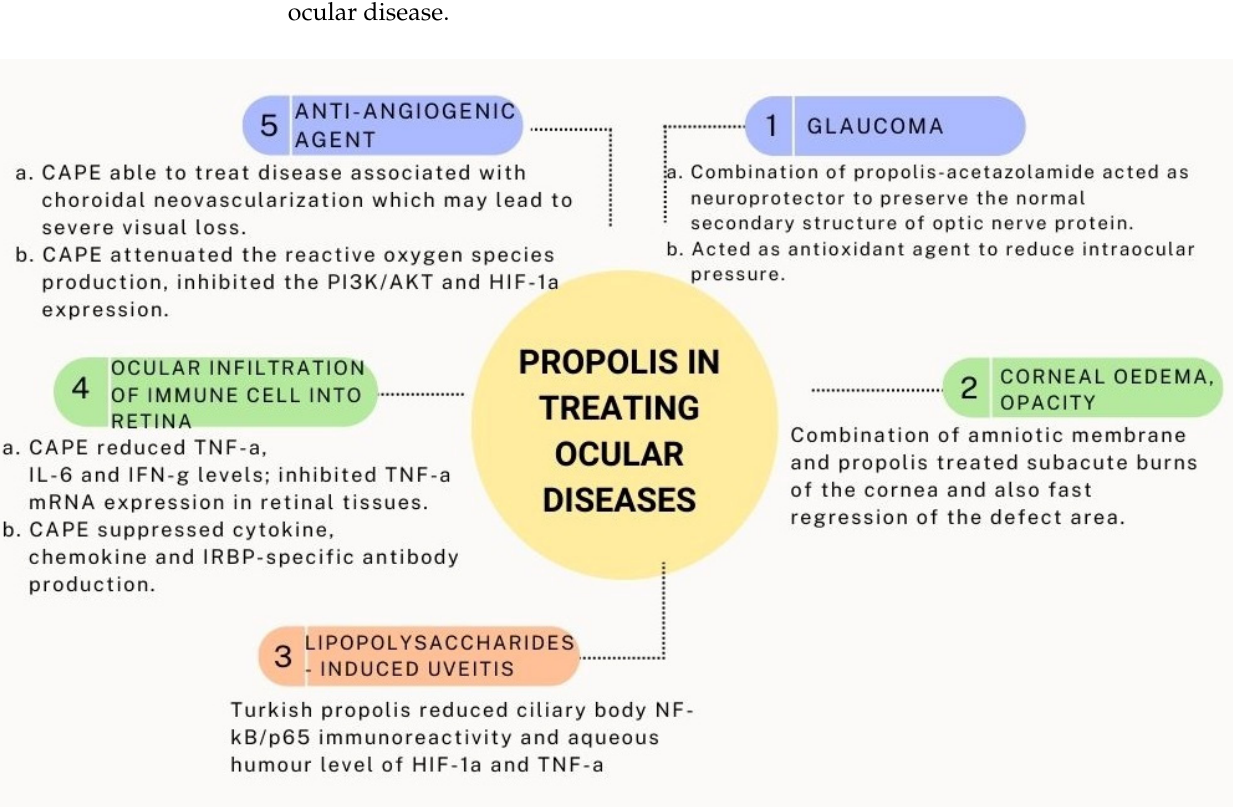
Figure 4. Medicinal values of propolis in treating ocular disease.